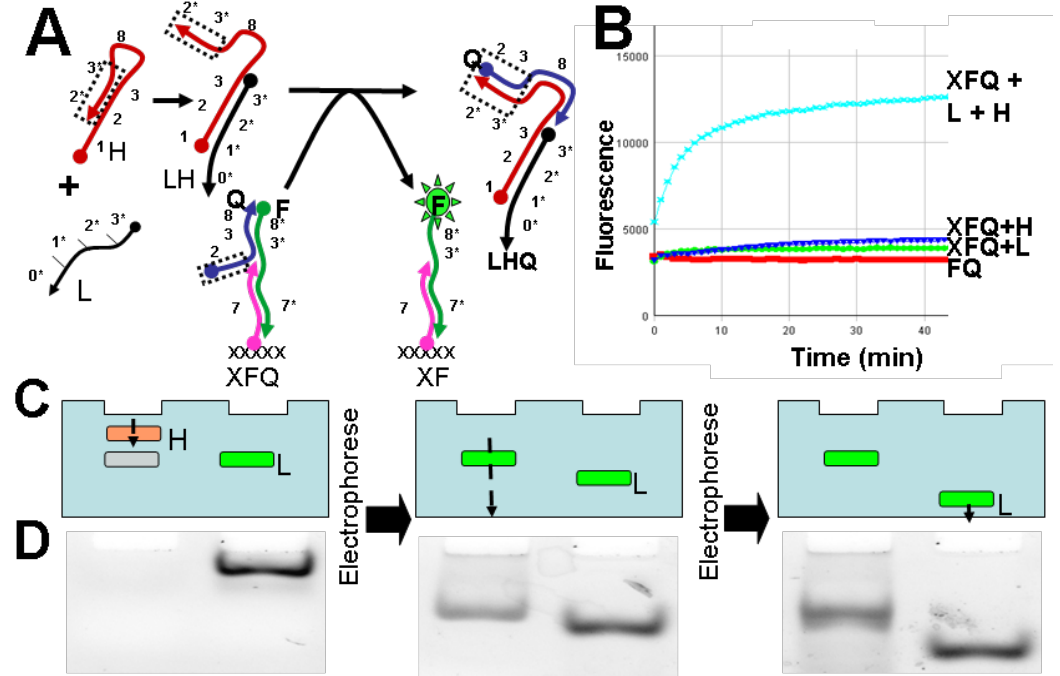
Figure 2. Strand displacement reactions produce a change in fluorescence. ( A ) Schematic of the design of the fluorogenic reaction. L and H interact via toehold domain 1 and complementary domain 1* to cause toehold opening. This activated L-H complex then reacts via toehold domain 2 on Q and 2* on H to abstract strand Q from FQX, leaving behind the newly fluorescent complex, FX; ( B ) Fluorescence detection of this reaction is shown over time. When all species are present (F-Q + L + H), fluorescence increases, while if any species are missing, fluorescence remains low; ( C ) A schematic diagram of the ( D ) experiment showing how L is loaded and allowed to electrophorese and is chased with H (first panel). When H reaches L, the fluorogenic reaction takes place with the XQF embedded homogeneously in the gel, generating a fluorescent feature (second panel) which stays fixed while the mobile L continues to move (third